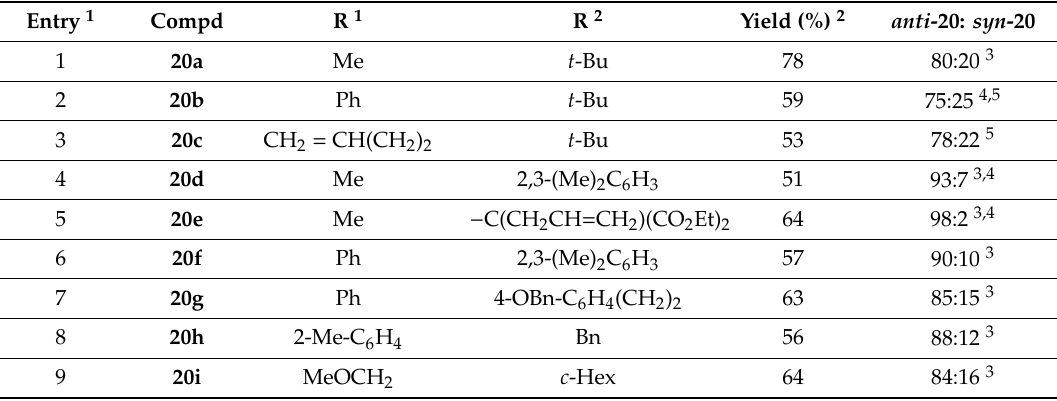
Scheme 6. Scope of the diastereoselective Passerini reaction. Table 3. Scope of the ZnBr 2 promoted Passerini.